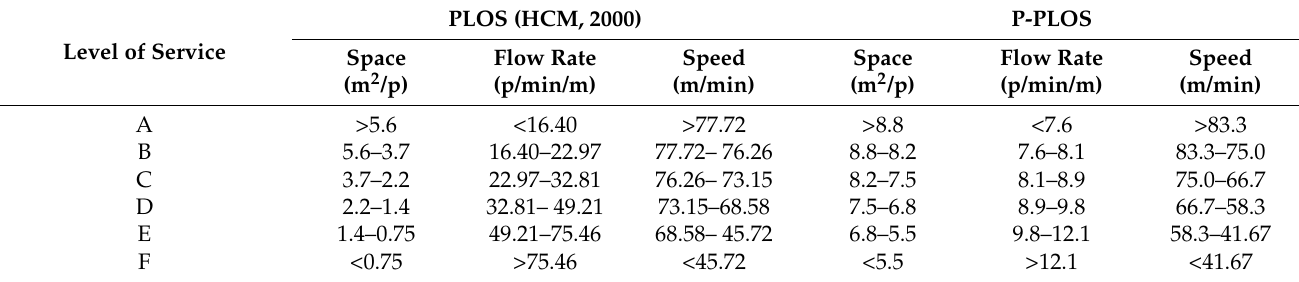
Table 2. Comparative values of PLOS and